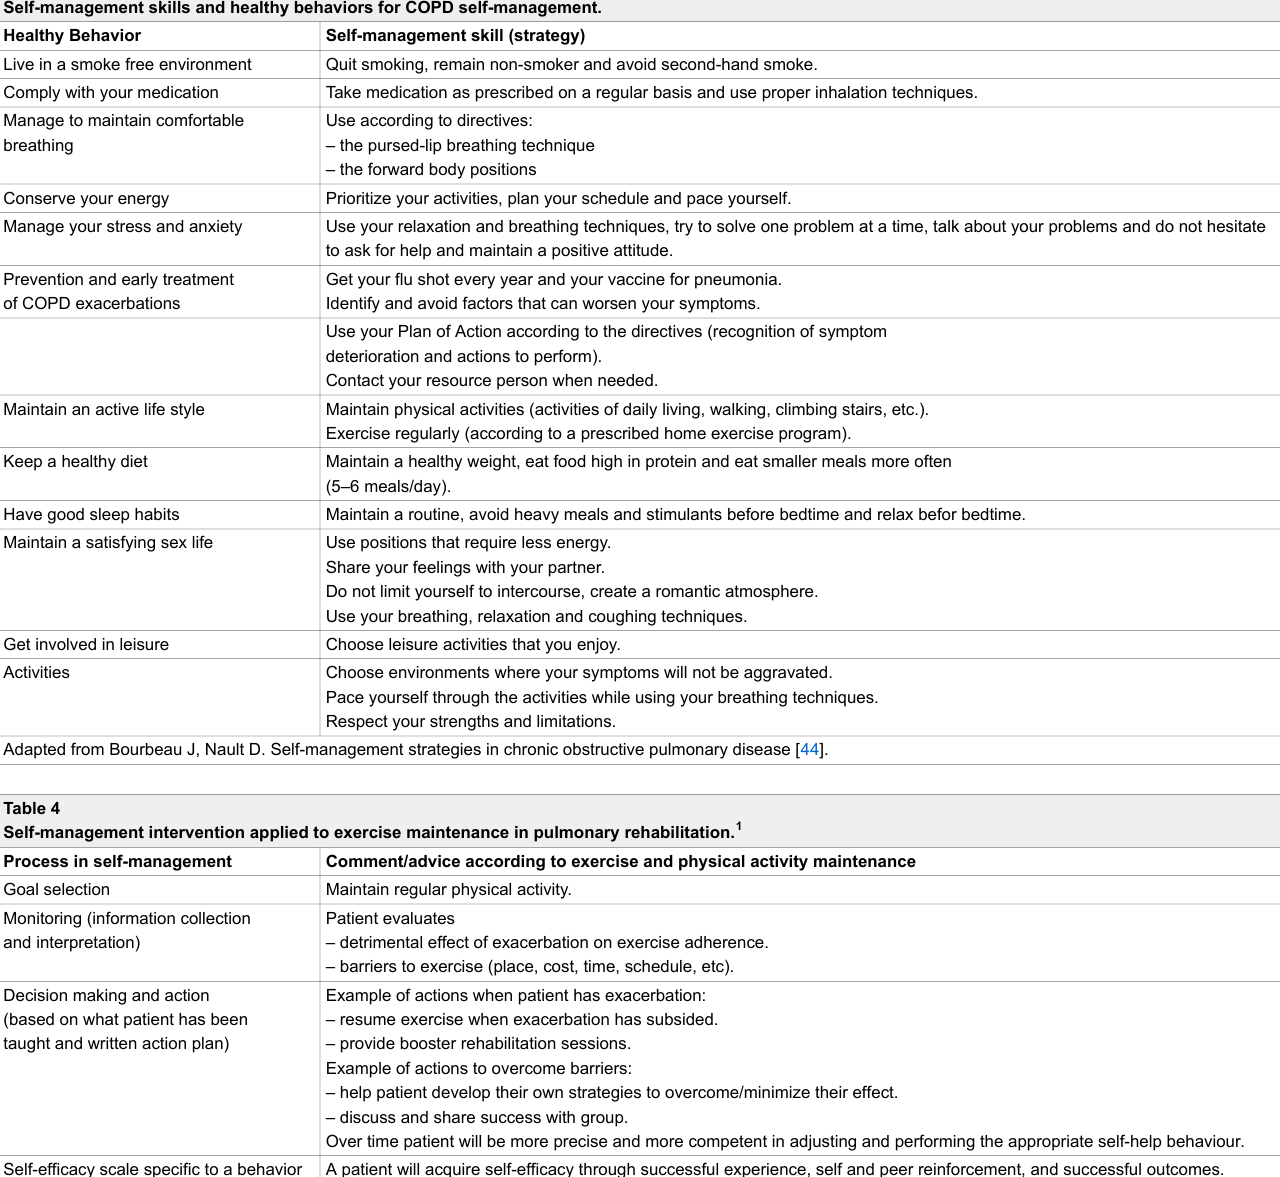
Table 3 Self-management skills and healthy behaviors for COPD self-management.